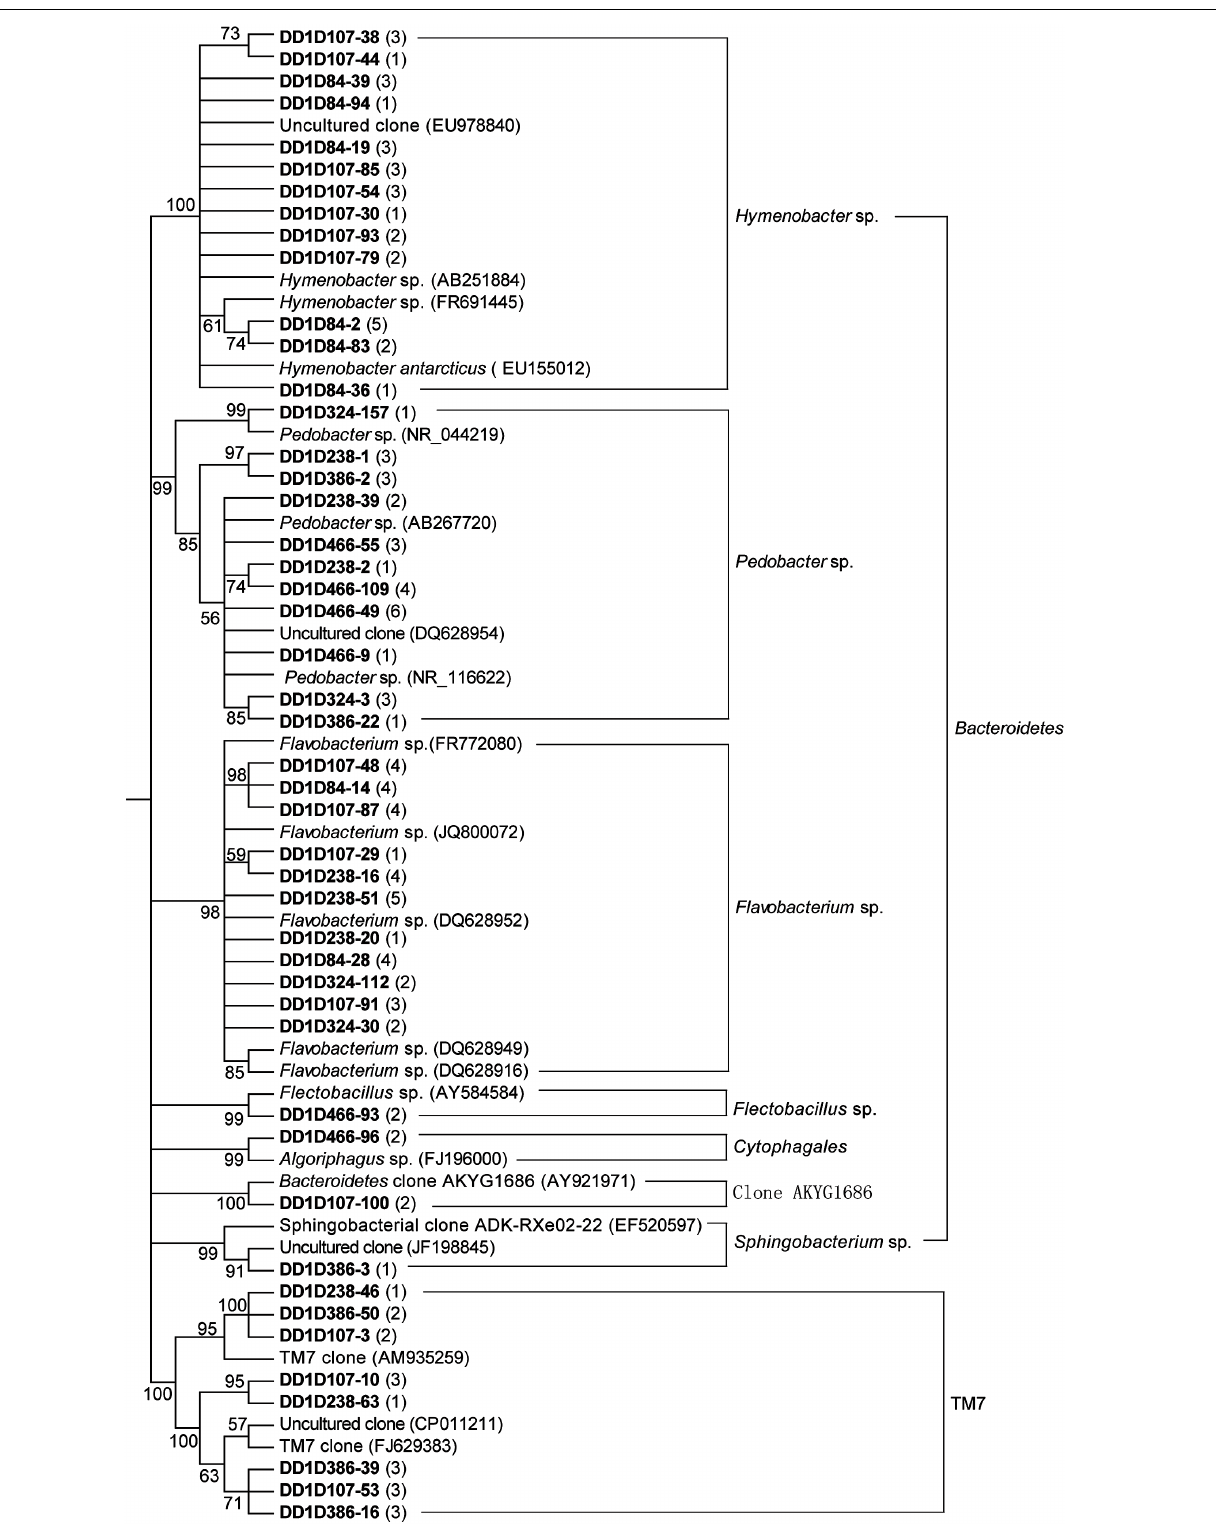
Frontiers in Microbiology |